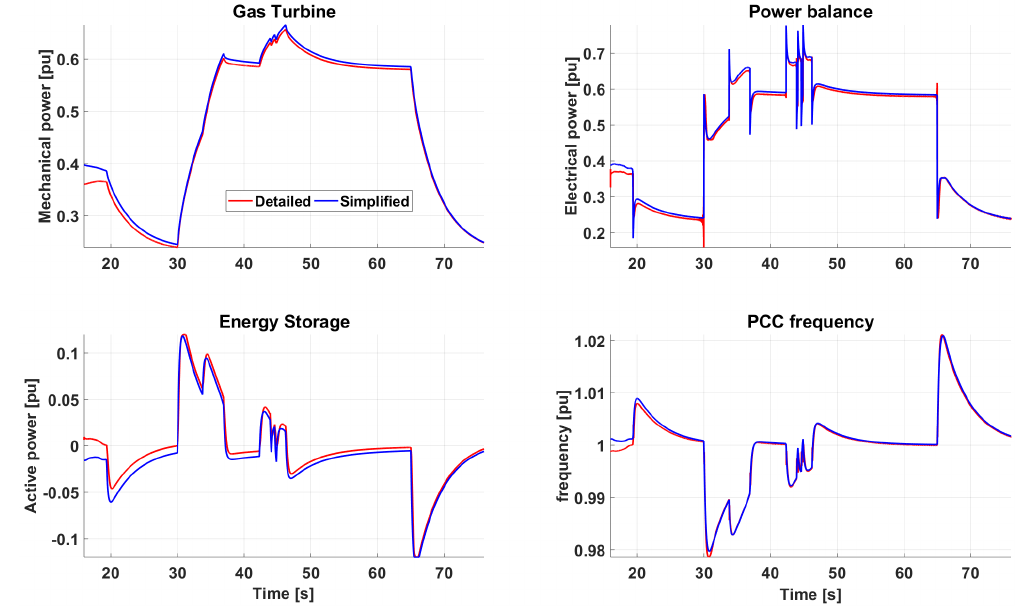
Figure 9. Detailed versus simplified model with